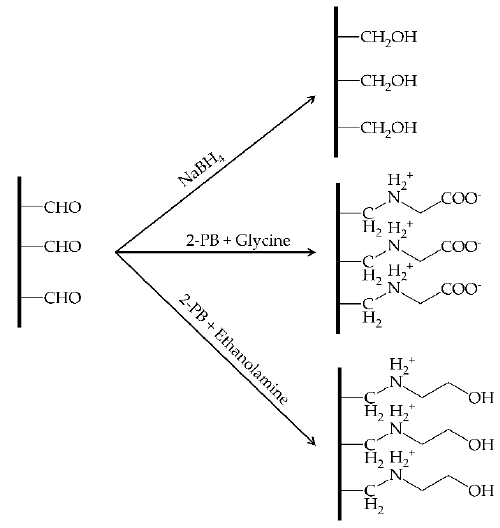
Figure 4. Scheme of the surface of the glyoxyl agarose support after three different reduction steps.